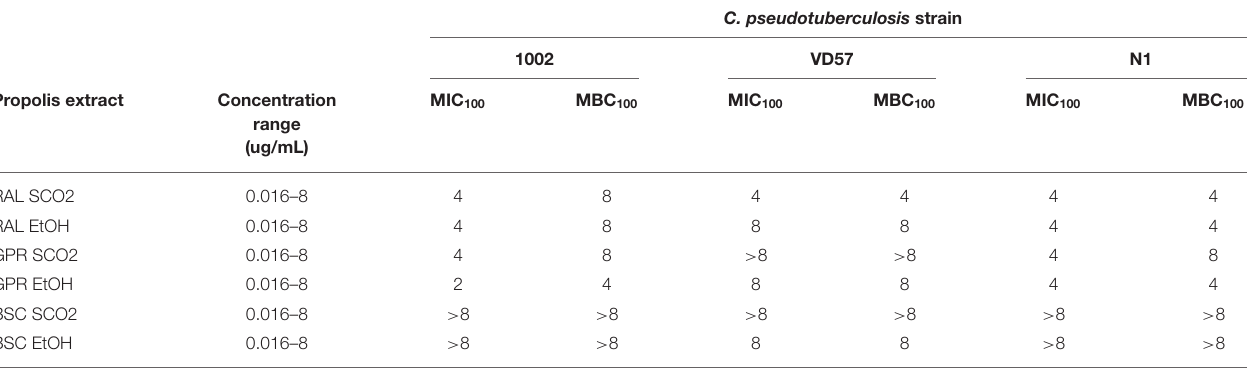
TABLE 4 | MIC 100 and MBC 100 of supercritical and ethanolic extracts of red, green, and brown propolis against isolates of C. pseudotuberculosis as determined by the broth microdilution method.